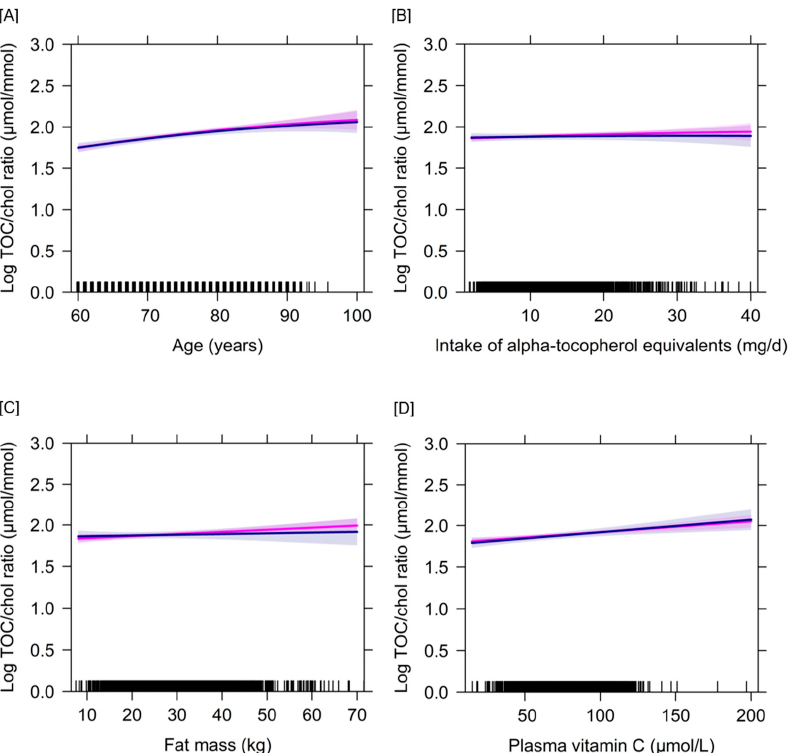
Figure 3. Longitudinal associations of the log α -tocopherol / total cholesterol ratio with age, intake of α -tocopherol equivalents, absolute fat mass and vitamin C plasma concentrations separated by sex.